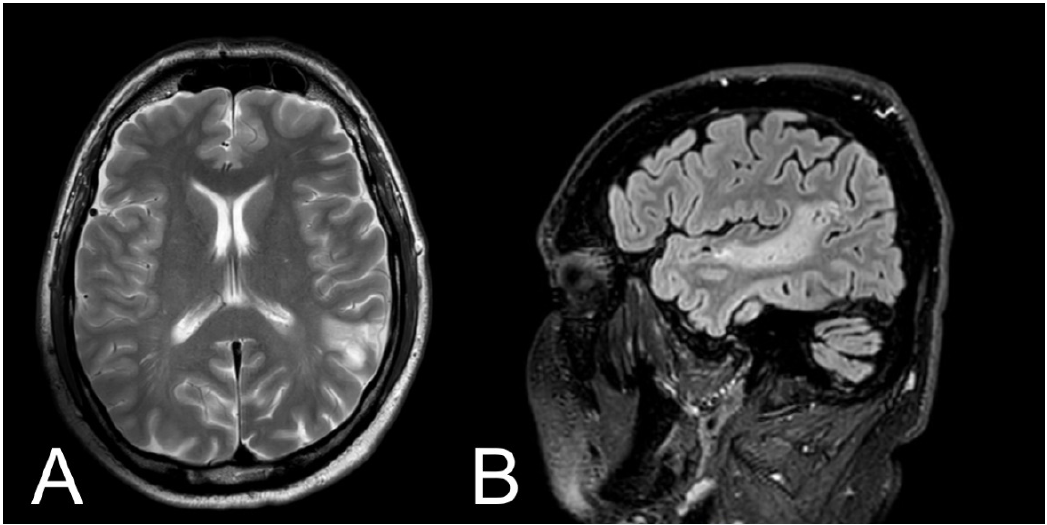
Figure 3. Magnetic resonance imaging (MRI) of the patient after 3 months. ( A ) T2-weighted image with axial plane (T2WI) showed decrease ischemic lesion in the left temporal lobe; ( B ) FLAIR image with sagittal plane showed decrease ischemic lesion without oedema of left temporal lobe.